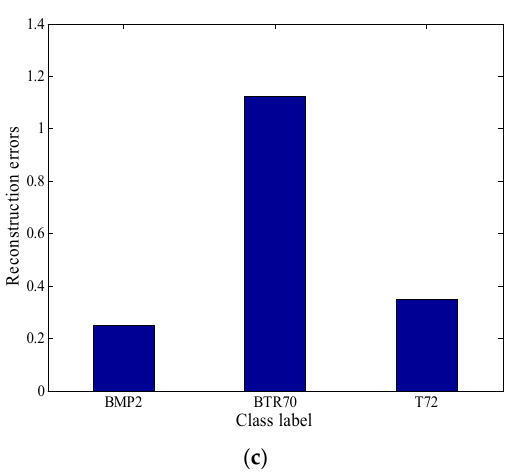
Figure 10. ( a ) BMP2 reconstruction errors of GADPL. ( b ) BTR70 reconstruction error of GADPL. ( c ) T72 reconstruction error of GADPL.